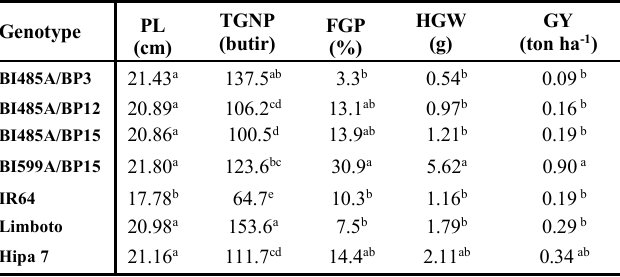
Table 6: Yield components and the yield including panicle length (PL), total grain number of panicle (TGNP), filled grain percentage (FGP), hill grain weight (HGW), and grain yield (GY) of hybrid rice genotypes and check varieties in rain-fed